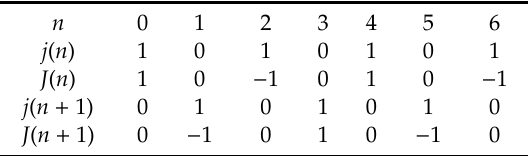
Table 1. Divalent and trivalent functions used in Equations